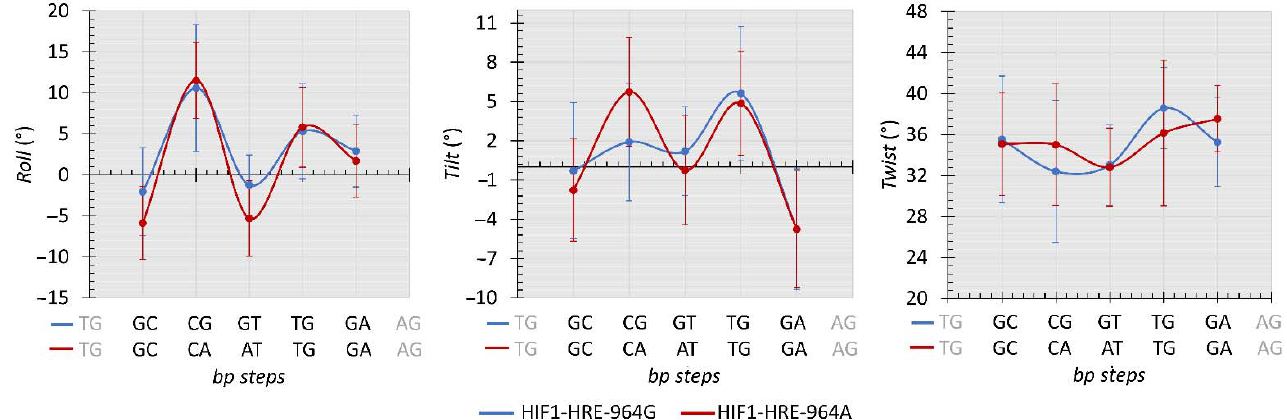
Figure 9. Average values ( ◦ ) comparison of the roll, tilt, and twist calculated for the HRE from HIF1-HRE-964G/A complexes trajectory atomic coordinates every 10 ns. Note: Author's own image.